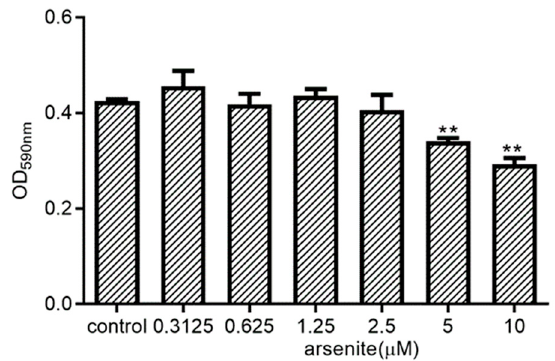
Figure 3. E ff ects of arsenite on the metabolic activity of 030D cells. 030D cells were incubated with the indicated concentrations of arsenite for 24 h. Metabolic activity, representative of cell viability, was evaluated in an MTT assay. Untreated cells were used as control. Y -axis: OD590, reflecting MTT reduction into purple colored formazan crystals which were solubilized before measurement (see Materials and Methods ). Data are shown as the mean ± SD and representative of three independent experiments. ** p < 0.01, vs. control group.